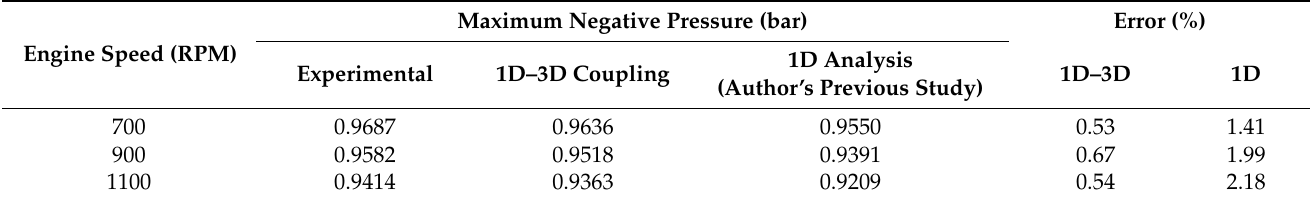
Table 3. Maximum negative pressure results of the 1D–3D gas flow analysis, experiment, and 1D gas flow analysis (author’s previous study) in the intake pipe when the air-intake valve was